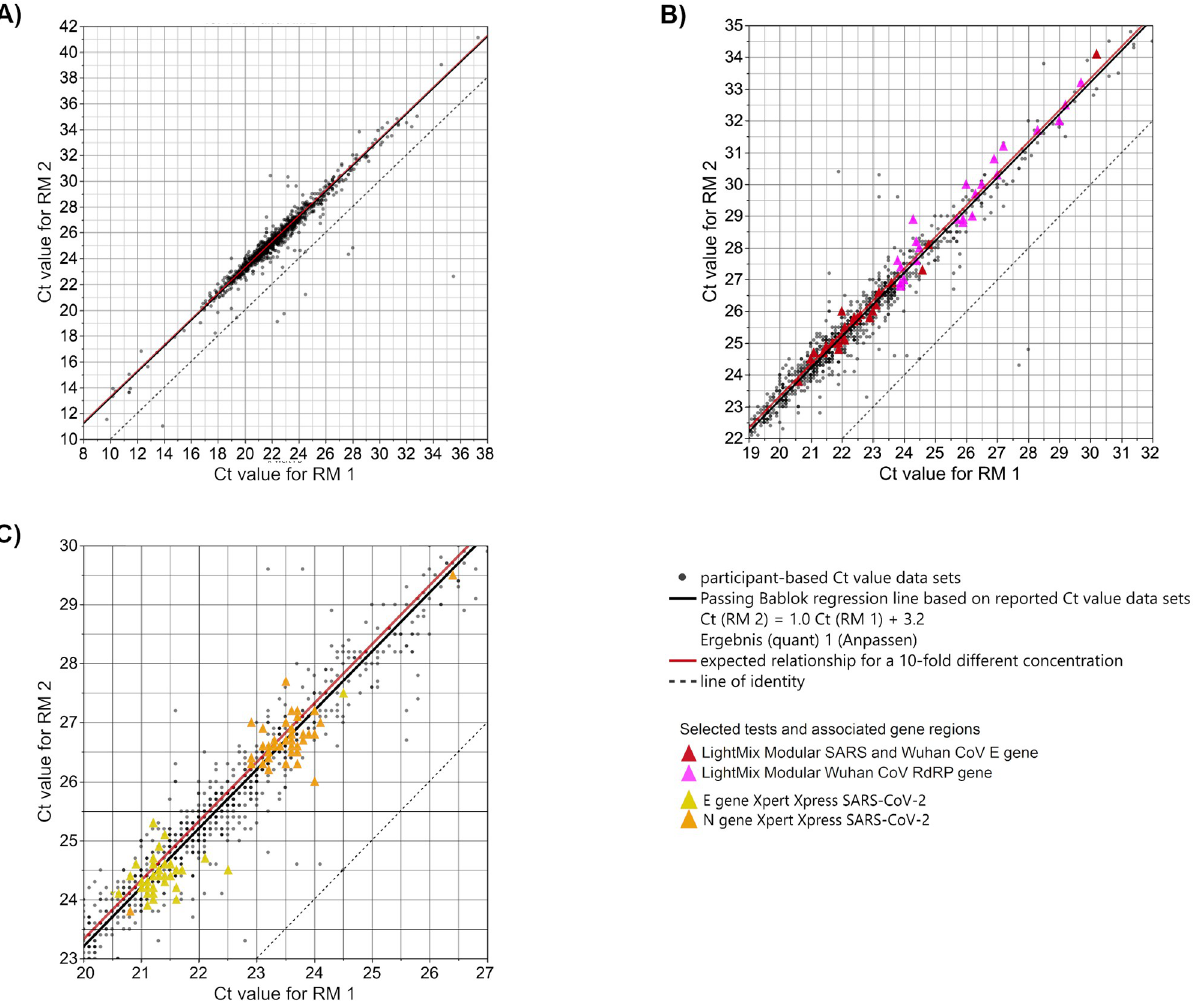
Fig 9. Analysis of participant-based Ct value correlation of both samples (A) with highlighted LightMix test systems (B) and Xpert Xpress test system (C). The concentration of RM 1 is estimated at roughly 10 7 copies/mL and the concentration of RM 2 is estimated at roughly 10 6 copies/mL. The results of all laboratories are plotted for both samples and corresponding Passing Bablok regression is shown (black regression line Ct (RM 2) = 1.0 Ct (RM 1) + 3.2), corresponding 95%-confidence limits are narrow and cannot be distinguished from the Passing Bablok regression line. Grey dashed line: line of identity. Exemplary test kits are highlighted with colour. The red line marks the expected relationship of Ct values for the two samples with concentration differences of a power of ten: Ct (RM 2) = 1.0 Ct (RM 1) +